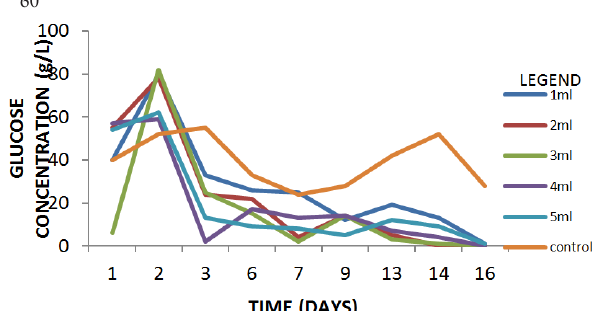
Fig. 2. Residual glucose during the fermentation with different inoculum sizes